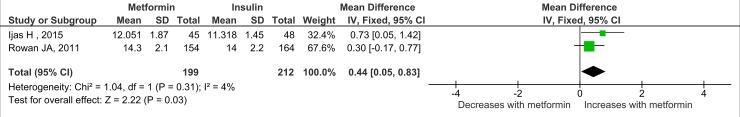
Infant weight.Expressed as mean differences (fixed effects model) and 95% CI. IV, mean difference.